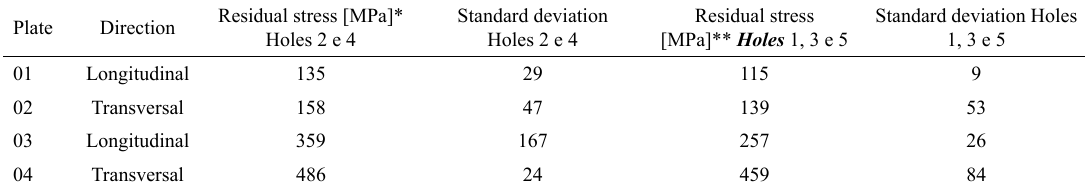
Table 2. Values of residual stresses